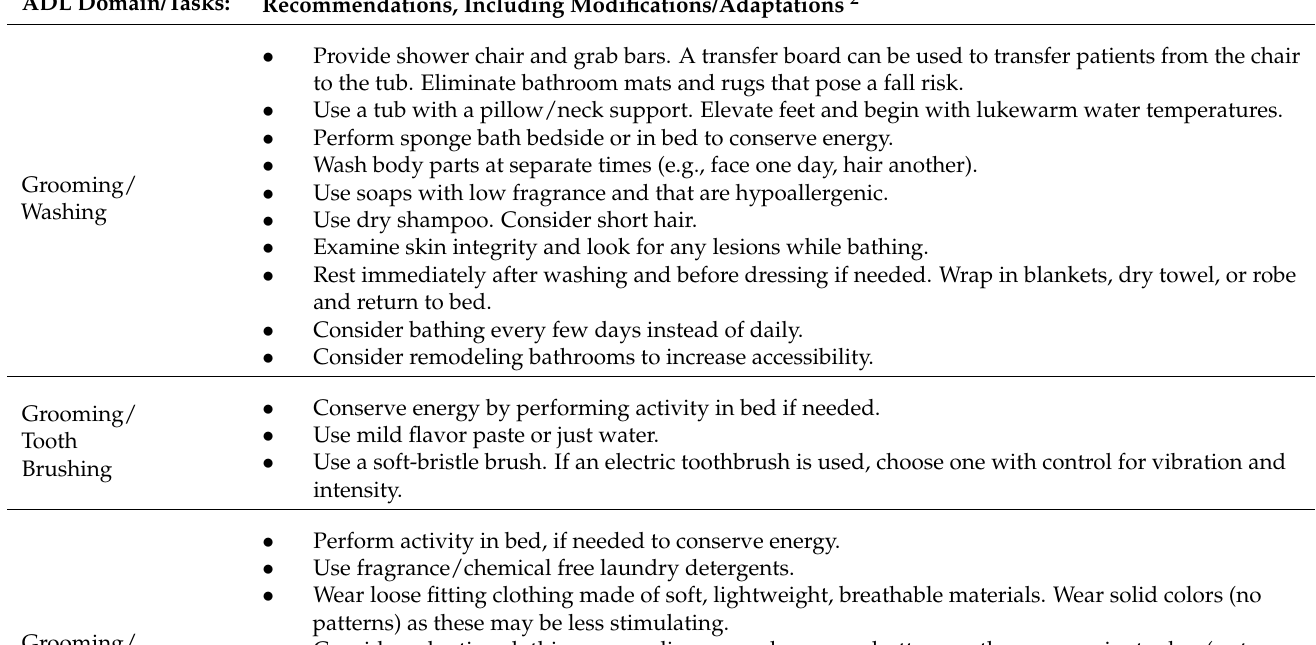
Table 2. Practical Recommendations for Energy Conservation and Management: Summary of ADLs to be evaluated in the bedbound patient and examples of corresponding activity modifications and adaptations that can be employed 1 . ADL Domain/Tasks: Recommendations, Including Modifications/Adaptations